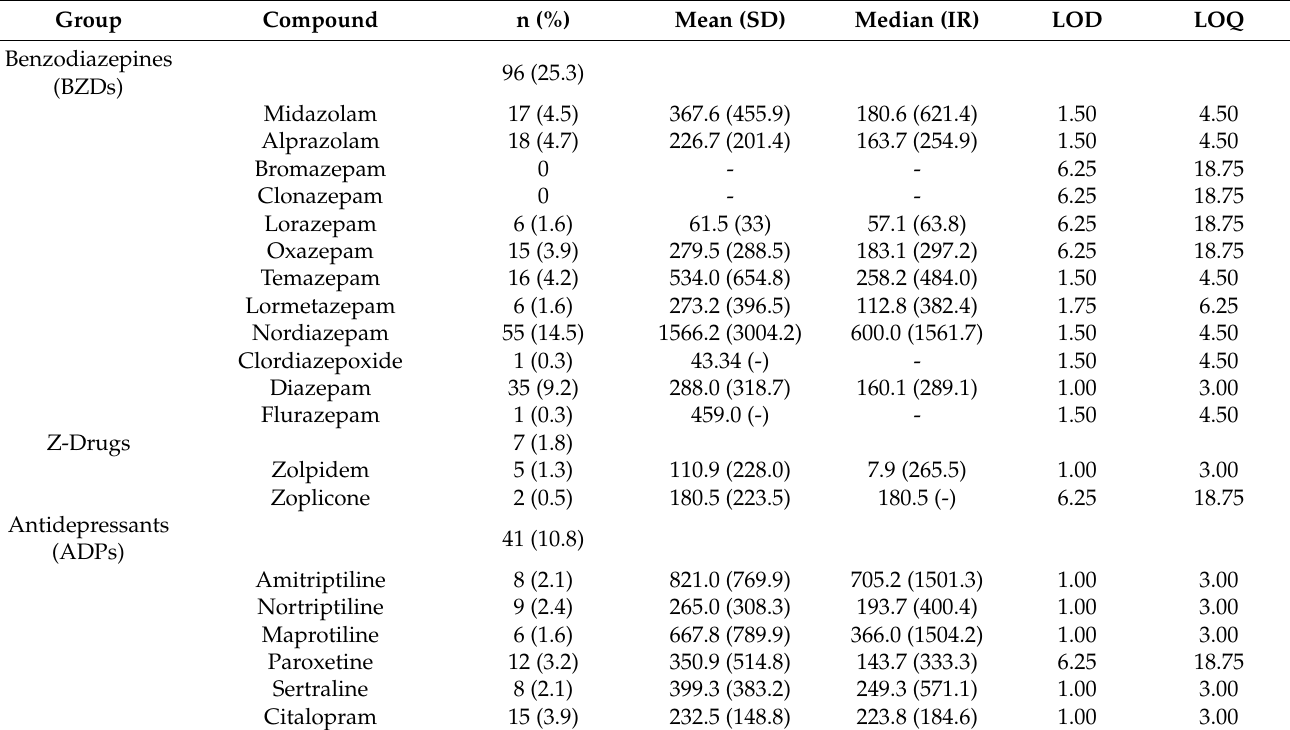
Table 2. Mean (and Standard Deviation) and Median (and Interquartile Range: